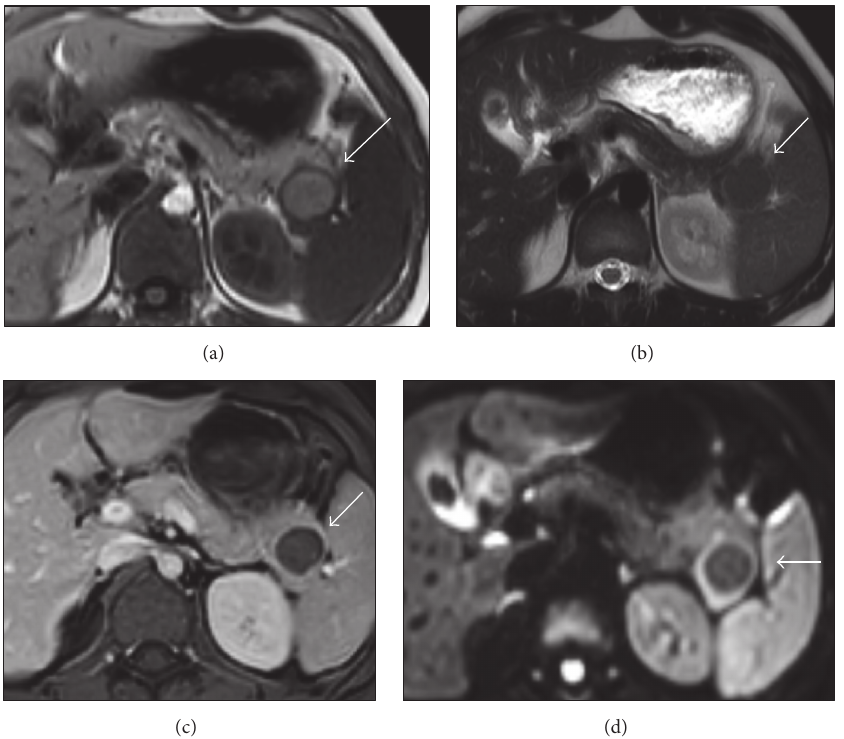
Figure 2: MRI exam showing (a) T1-weighted image, (b) T2-weighted image, (c) Gd-enhanced image, and (d) DWI image of the lesion. Note how DWI best demarcates soft-tissue rim surrounding cystic component, with equivalent signal intensity to